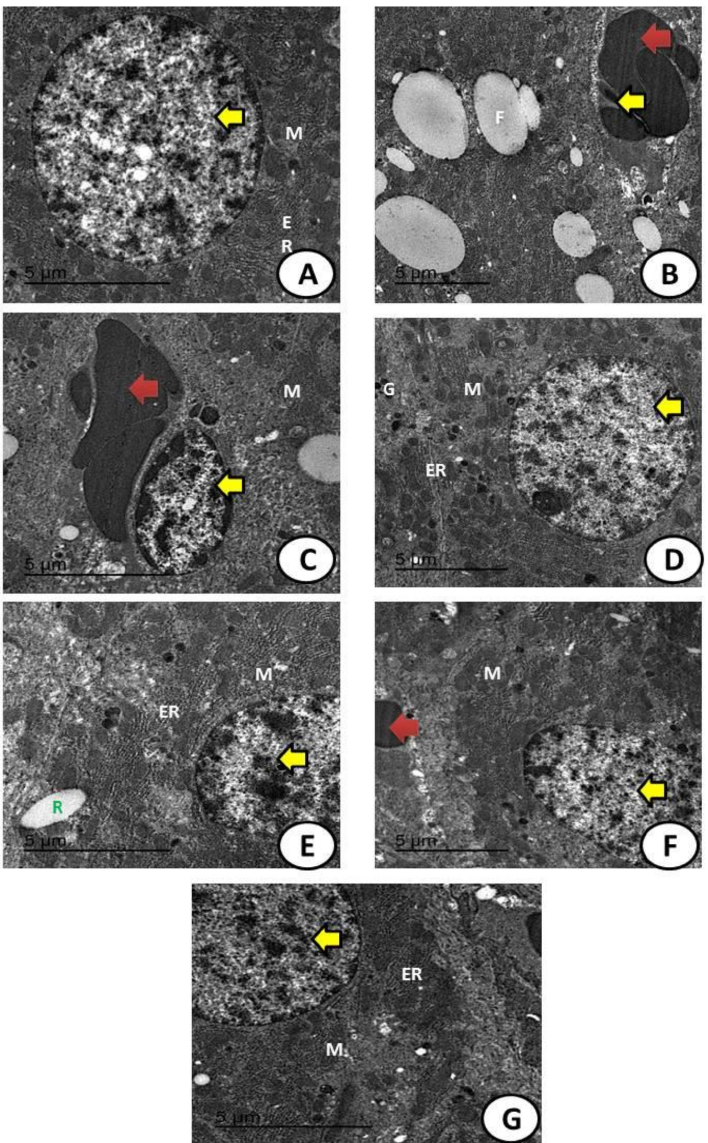
Figure 12. An electron micrograph of hepatic tissues of ( A ), the control group showed a normal nucleus (yellow arrow) with the continuous nuclear membrane and the appearance of normal-sized mitochondria (M) and endoplasmic reticulum (ER). ( B ) The MoO 3 -NPs treated group shows detached hepatic parenchyma with large fat droplets as a sort of fatty change (F) and the appearance of hemorrhage (red arrow) and necrotic nucleus (yellow arrow) with reduced mitochondria. ( C ) The CdCl 2 treated group with apoptotic nuclei (yellow arrow) and hemorrhage (red arrow) as well as degenerated mitochondria (M). ( D ) The RJ treated group with a normal nucleus (yellow arrow) and continuous nuclear membrane, as well as normal-sized M, ER, and glycogen granules (g). ( E ) The MO-NPs and RJ treated groups demonstrated restoration of the normal-sized nucleus (yellow arrow) with mitochondria and ER, as well as partial MoO 3 -NP residues (R). ( F ) The CdCl 2 and RJ treated groups show restoration of the normal-sized nucleus (yellow arrow) with the appearance of small red blood cells (red arrow). ( G ) The MoO 3 -NPs and CdCl 2 followed by RJ treated group showed restoration of the normal-sized nucleus (yellow arrow) with the appearance of normal endoplasmic reticulum (ER) and mitochondria (M) with fewer fatty